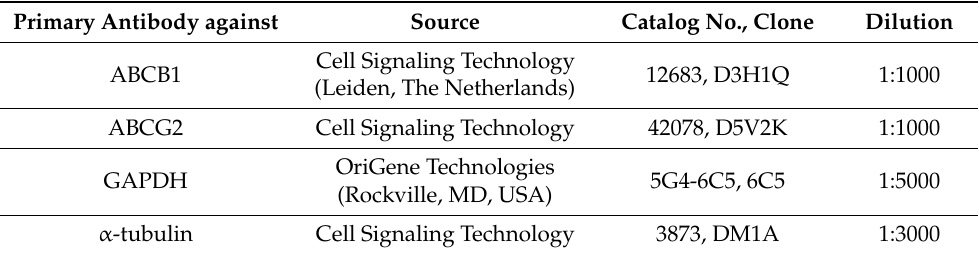
Table 1. Primary antibodies for Western blot analysis.